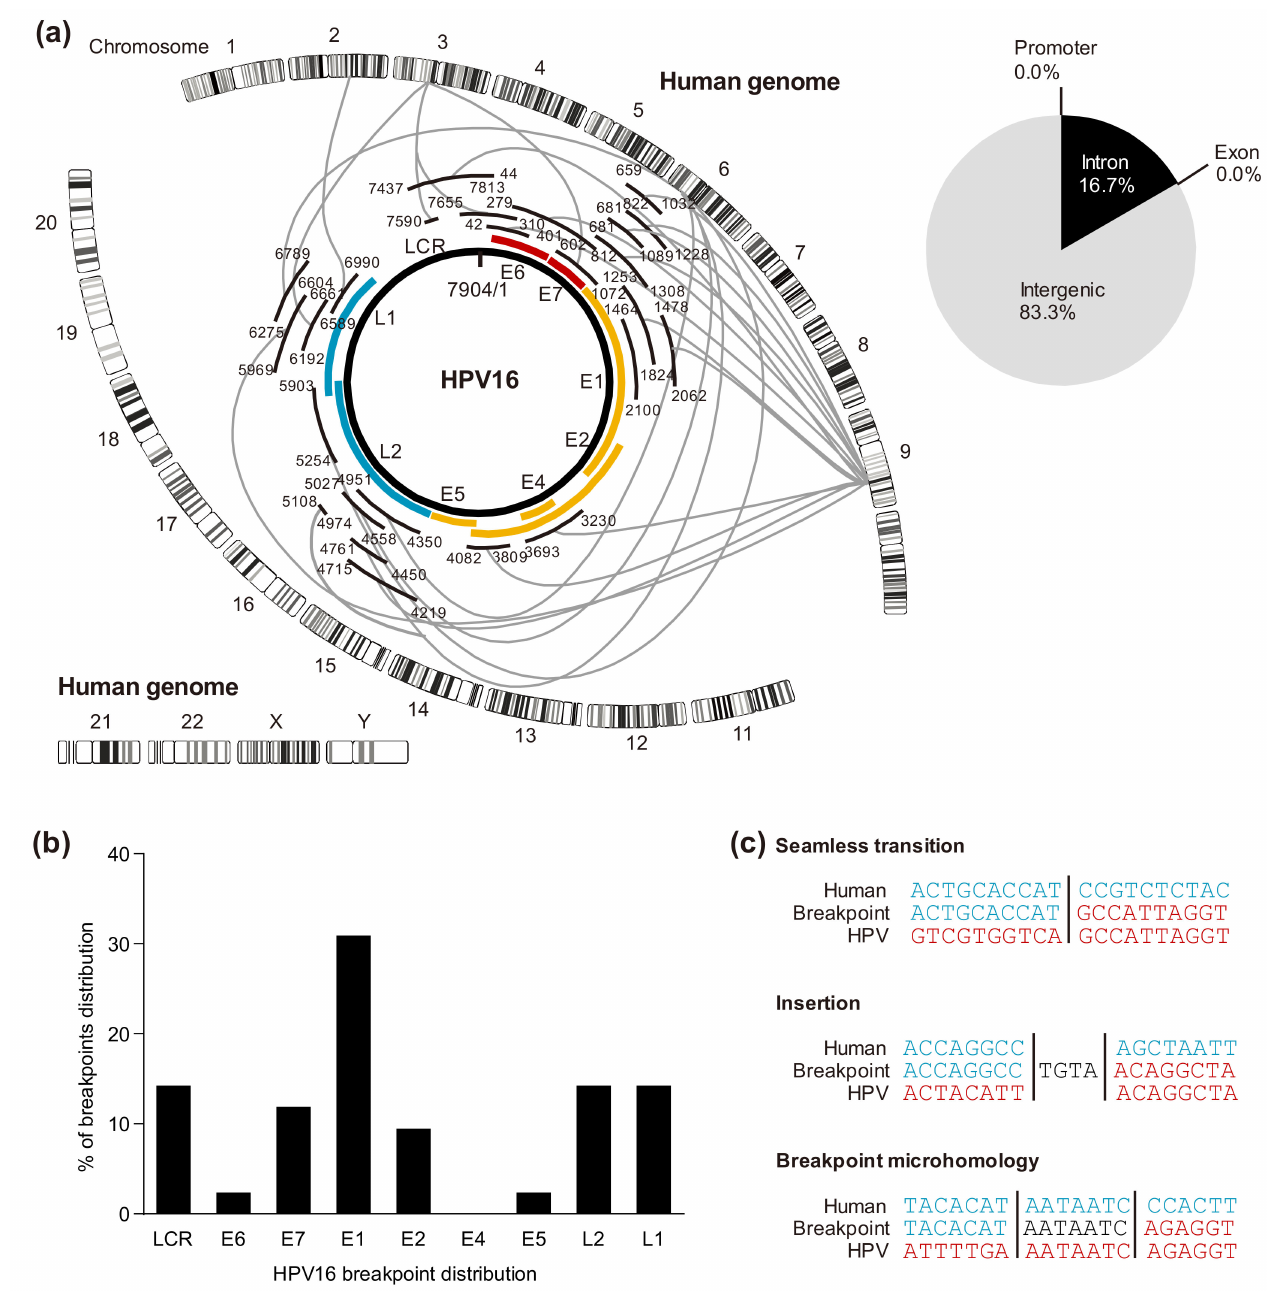
Figure 3. ( a ) Integration breakpoint distribution in human chromosomes and HPV16 genome represented by Circos plots of the UCSC:SCC090 genome. ( b ) Breakpoint distribution percentage in HPV16 cell lines (UCSC:SCC090, UCSC:SCC152, UCSC:SCC154). ( c ) Categories of viral-host breakpoints; (1) Seamless transition with defined breakpoint. (2) Insertion; nucleotides that align to neither reference genome. (3) Breakpoint microhomology; nucleotides that align to both refer- ence